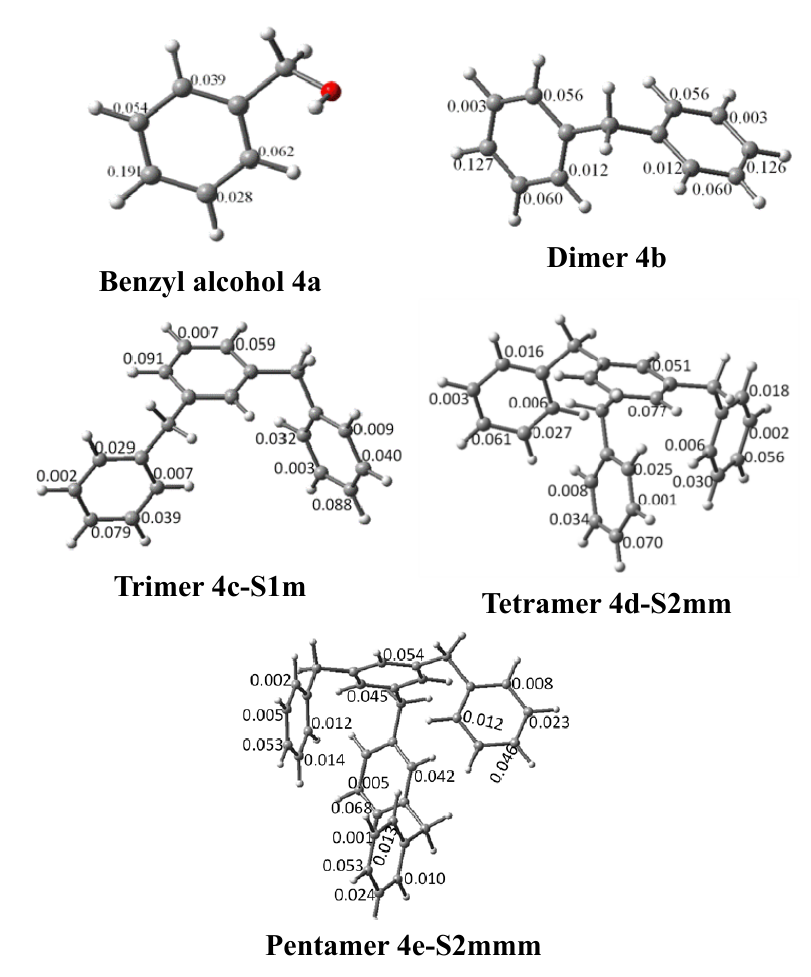
Figure 5. Optimised structures obtained at the B3LYP/6-311G(d,p) level.